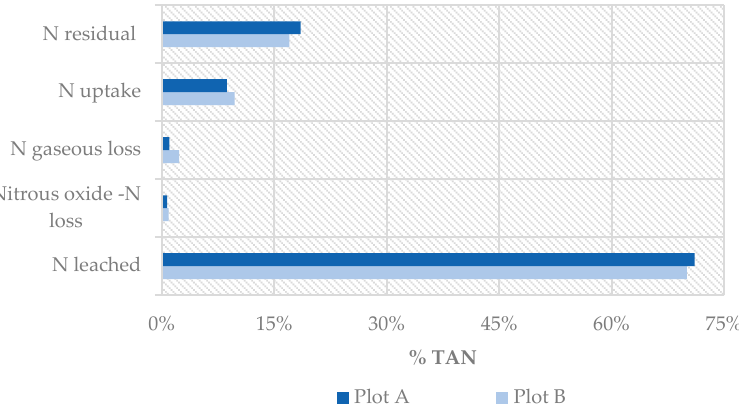
Figure 8. Mean values of crop N uptake, residual soil N (0–90 cm), leached N, and N lost to the atmosphere (N 2 O loss and N gaseous loss), as percentage of total available soil N (TAN) for the plots A and B.